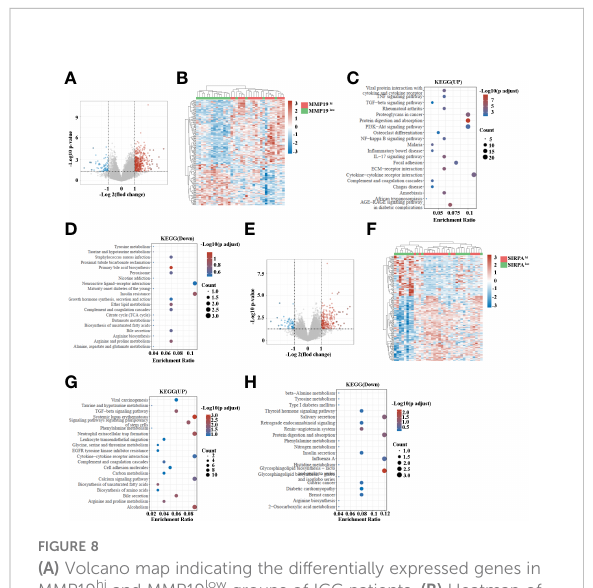
FIGURE 8 (A) Volcano map indicating the differentially expressed genes in MMP19 hi and MMP19 low groups of ICC patients. (B) Heatmap of differentially expressed genes in MMP19 hi and MMP19 low groups of ICC patients. (C) The upregulated KEGG pathways in the MMP19 hi ICC patients. (D) The downregulated KEGG pathways in the MMP19 hi ICC patients. (E) Volcano map indicating the differentially expressed genes in SIRP a hi and SIRP a low groups of ICC patients. (F) Heatmap of differentially expressed genes in SIRP a hi and SIRP a low groups of ICC patients. (G) The upregulated KEGG pathways in the SIRP a hi ICC patients. (H) The downregulated KEGG pathways in the SIRP a hi ICC